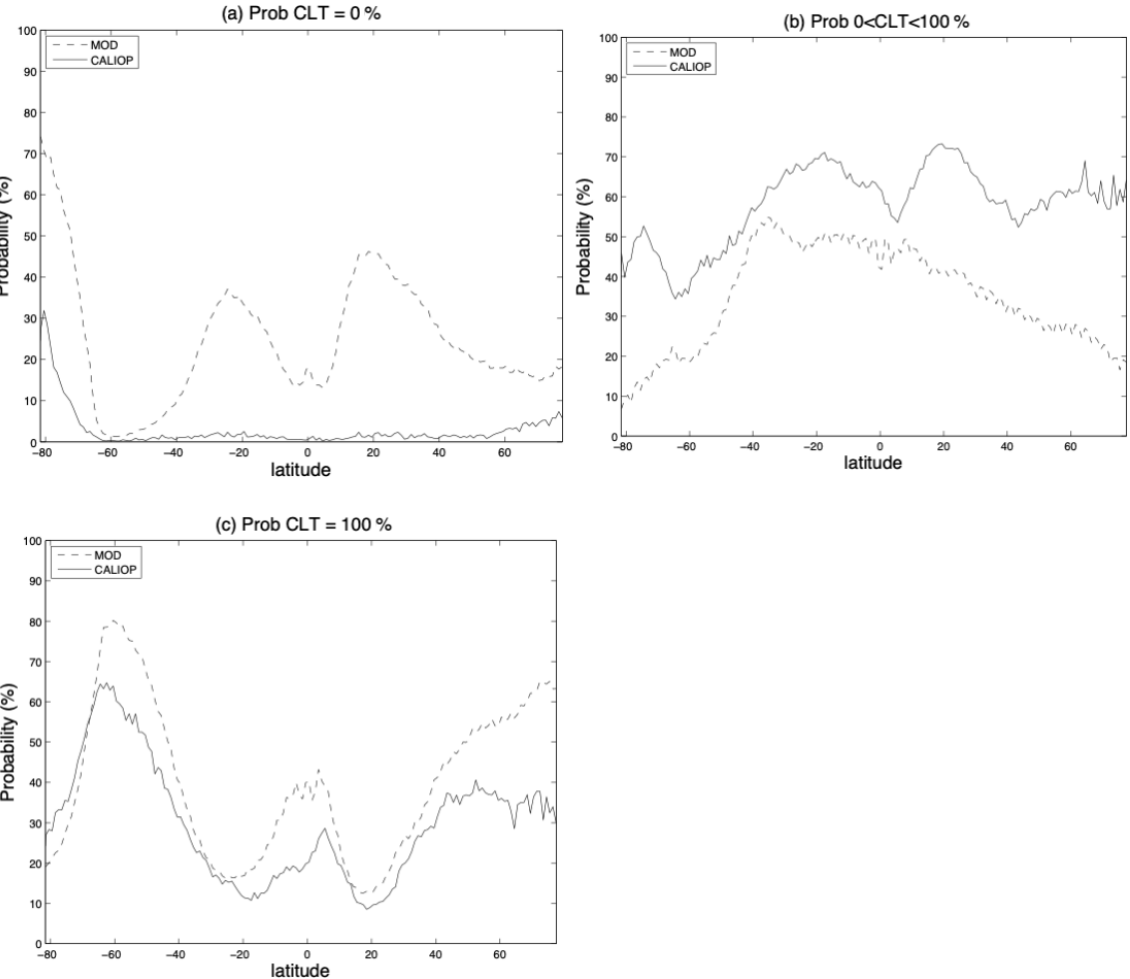
Figure 10. Probabilities of (a) cloud-free, (b) partially cloud covered, and (c) totally cloud covered 1 ◦ × 1 ◦ horizontal grid cells as a function of latitude, during the MAM period (nighttime), in CALIOP and